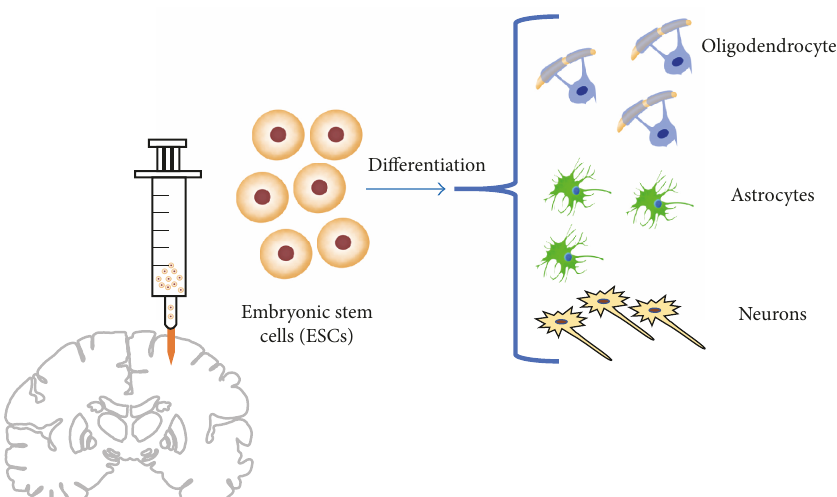
Figure 3: This fi gure demonstrates the e ff ects of ESC transplantation into the brain. When ischemic stroke occurs, ESCs promote neuronal di ff erentiation in both neurogenic and nonneurogenic regions, such as the striatum. ESCs are able to respond to environmental changes after ischemic insult and improve the capacity to promote